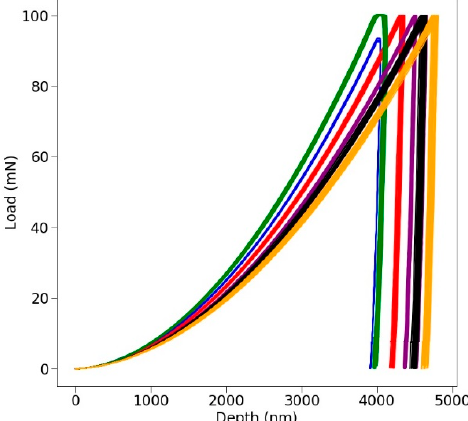
Figure 1. Load vs. depth curves for all 116 nanoindentation hardness tests performed on halite. Each color represents ~20 tests at target strain rates of 0.40 (green), 0.14 (blue), 0.05 (red), 0.015 (purple), 0.0075 (black), and 0.0015 (orange) s -1 . The nearly vertical unloading portion of the data indicates that plasticity dominates the deformation and that very little elastic recovery occurs at the end of the test.